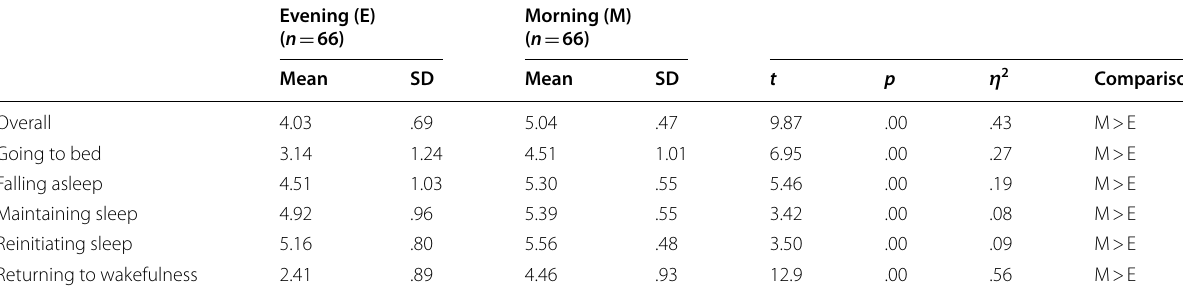
Table 2 Sleep Quality Differences in